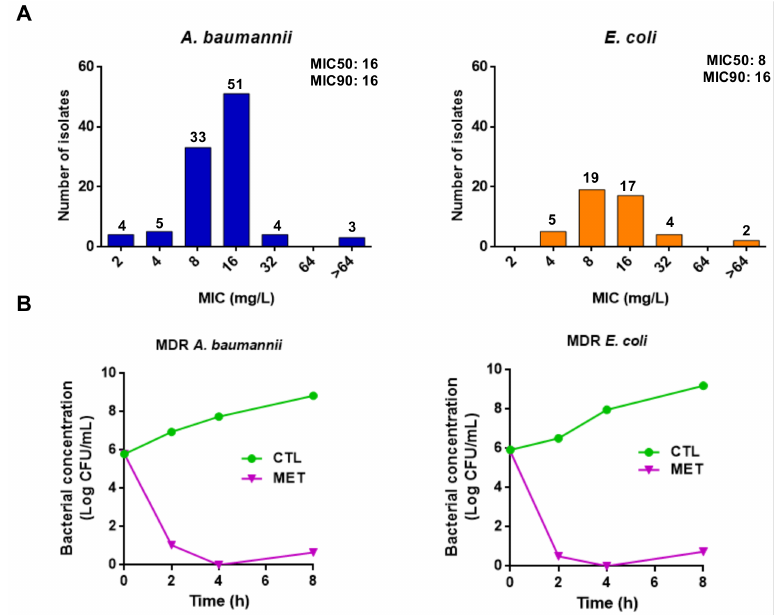
Figure 1. Tamoxifen metabolites present antibacterial activity against A. baumannii and E. coli . ( A ) Histogram distribution of MIC for the three tamoxifen metabolites mixture against a collection of A. baumannii and E. coli . ( B ) Time-kill curves of the multidrug-resistant (MDR) A. baumannii Ab186 and E. coli EcMCR+ strains alone and in the presence of metabolites mixture (4 × MIC) for 8